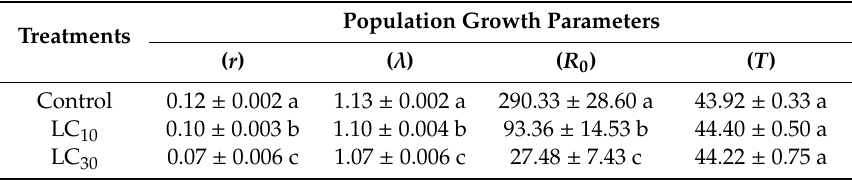
Table 4. Sublethal effects of chlorpyrifos on the population growth parameters (mean ± SE) of H. axyridis adults exposed to insecticide from the third instar larval stage.